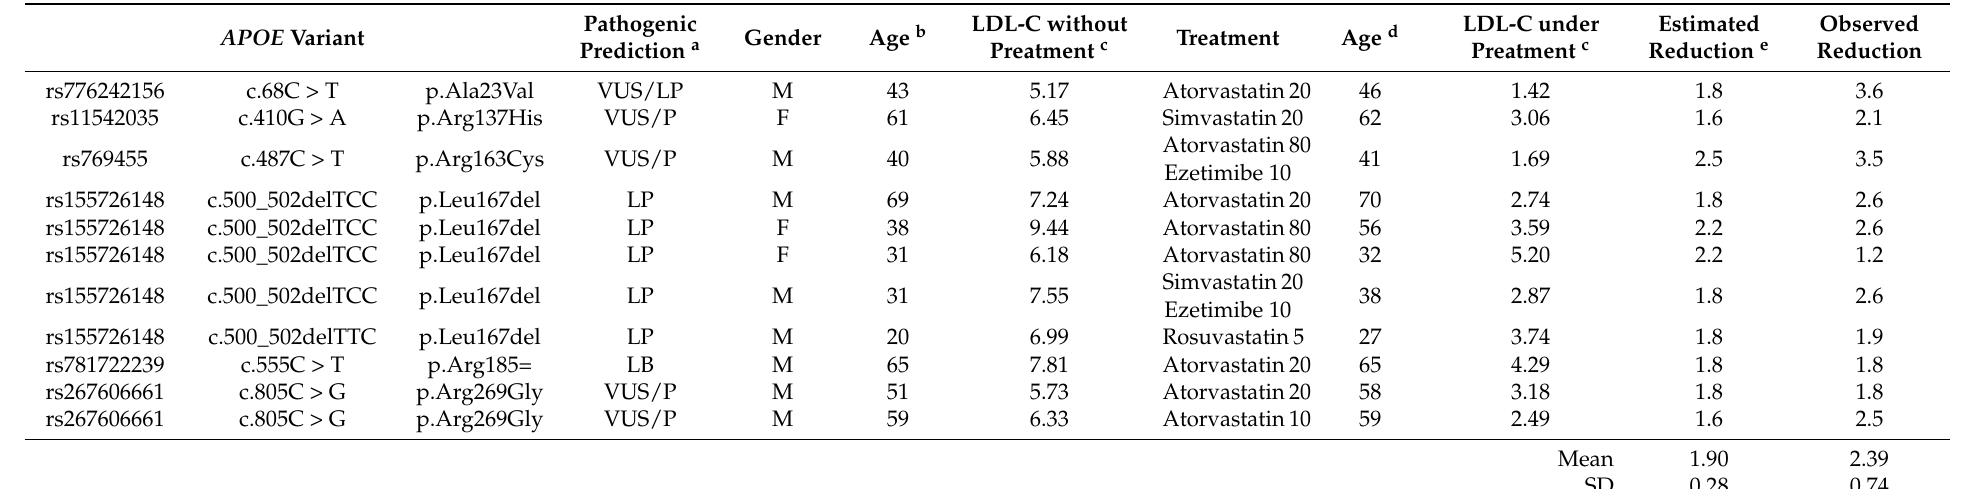
Table 3. LDL-C reduction under